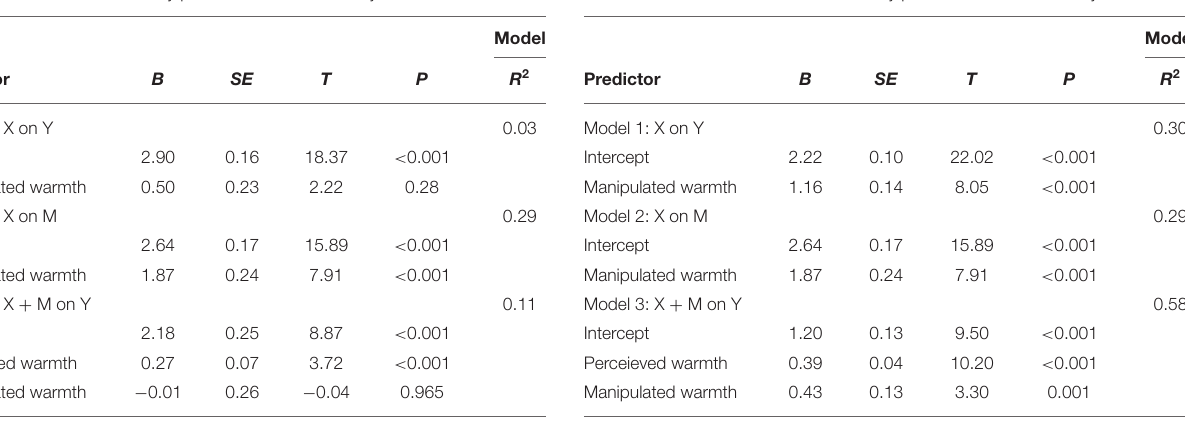
9. Experience with robots